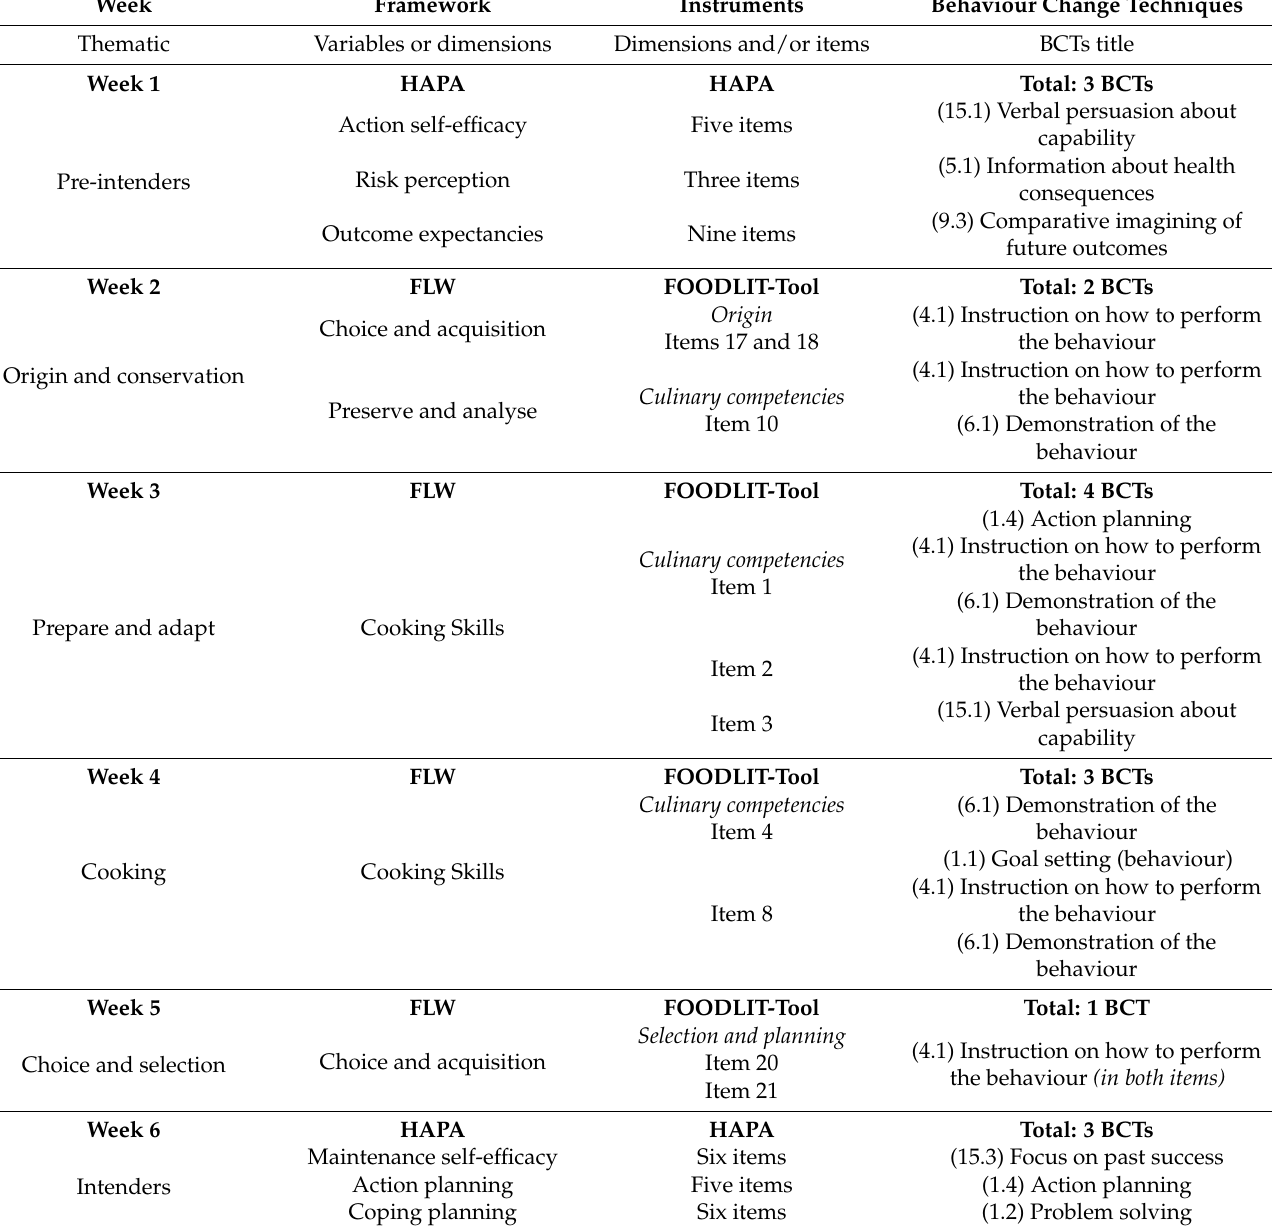
Table 1. Description of the experimental group intervention, including (i) the weekly thematic; (ii) its correspondent frameworks, including the Food Literacy Wheel (FLW) and the Health Action Process Approach (HAPA); (iii) the instruments used for weekly assessment, entailing either items from the FOODLIT-Tool or the HAPA; and (iv) the identification of the each behaviour change technique (BCT) used across all weeks, customised to the thematic’s